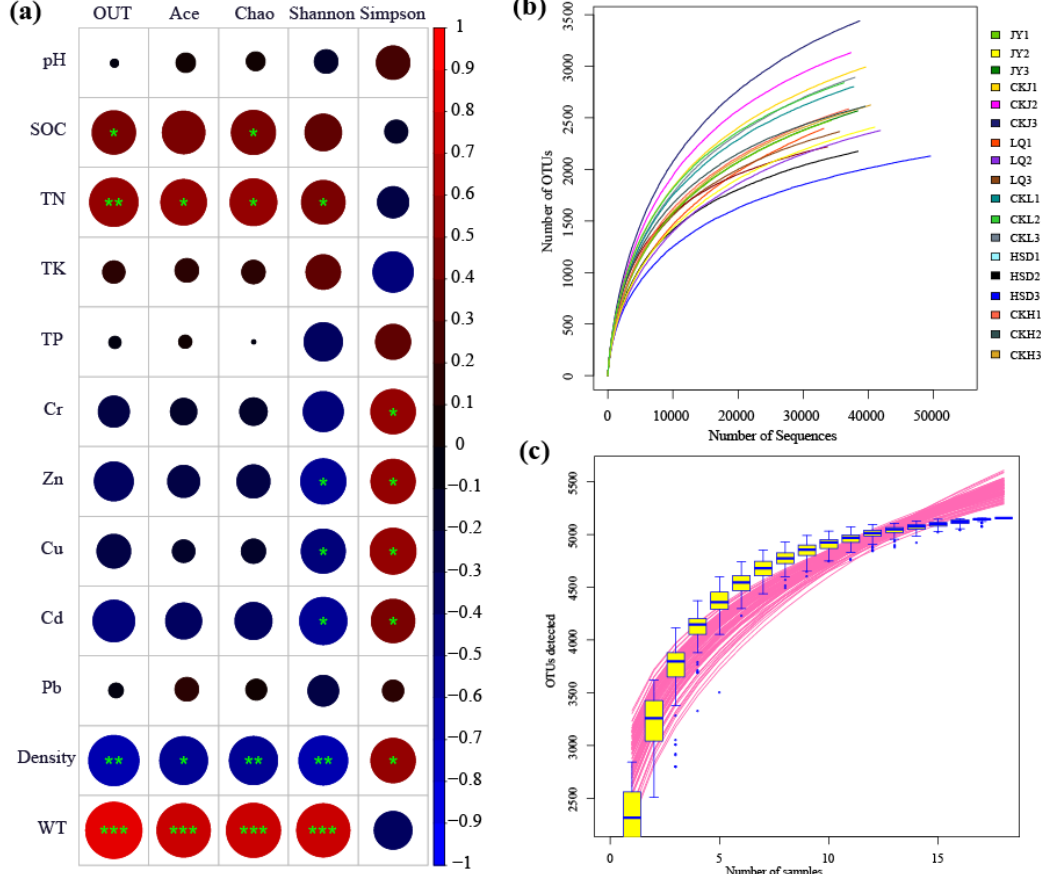
Figure 2. Pearson correlation heat map with correlation coefficient and significance levels based on the bacterial alpha-diversity estimators and environmental factors ( a ). * indicates significance test p < 0.05; ** indicates significance test p < 0.01; ***indicates significance test p < 0.001. Rarefaction curve ( b ) and species accumulation curves ( c ) of the 18 soil samples taken at the three turfy swamp sites.